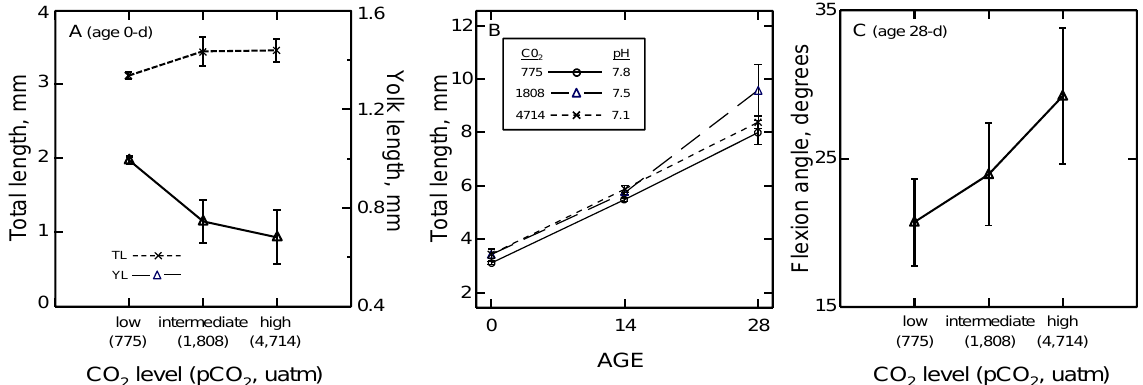
Fig. 5. Responses of summer flounder larvae to different levels of CO 2 in rearing water (inset: CO 2 levels (µatm) and associated pH values). (A) Total length (TL) and yolk length (YL) of larvae at hatching (0dph). (B) Total length versus age of larvae. (C) Notochord angle of advanced larvae (28dph) as an indicator of larval developmental stage. Flexion angle (see Fig. 1b) increases from zero as metamorphosis is approached. Data plotted are means ± SE.